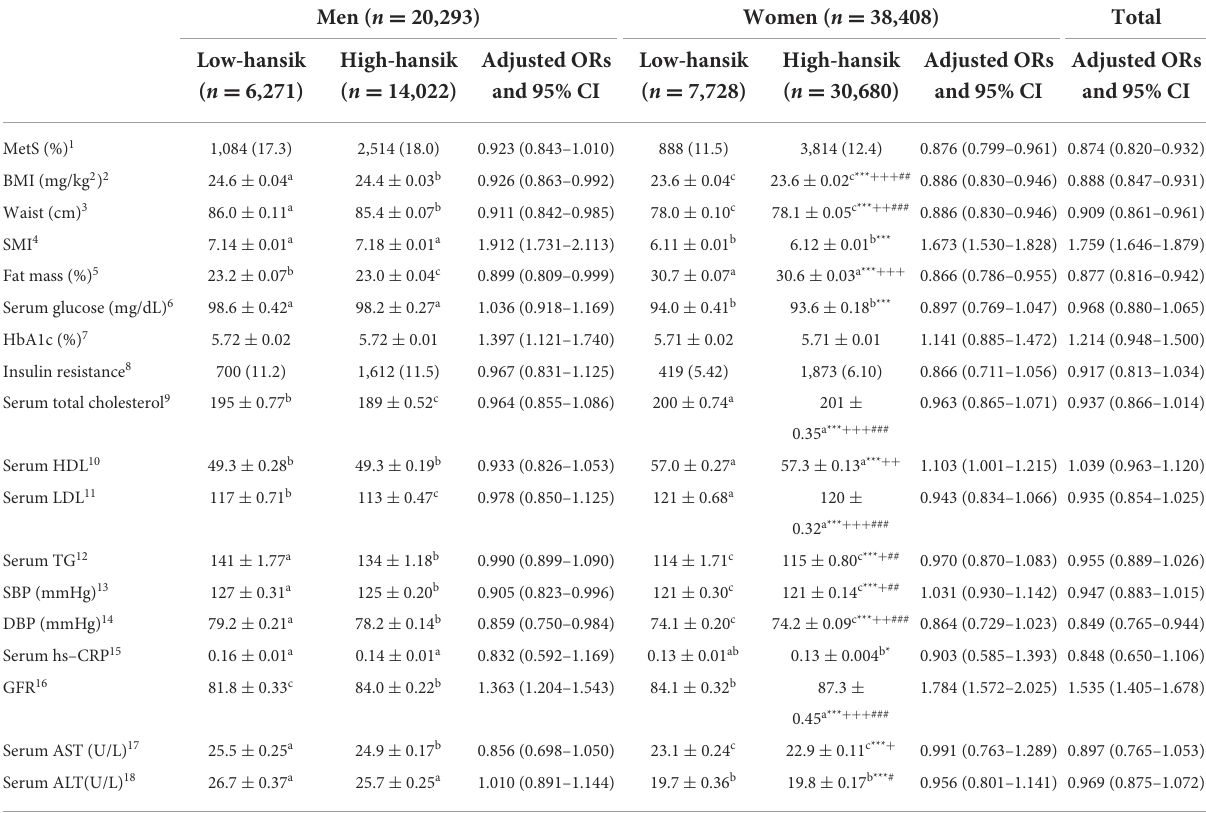
TABLE 6 Characteristics of metabolic parameters according to gender and hansik intake defined by the K diet -index score and their associations. Men ( n = 20,293) Women ( n = 38,408) Total Low-hansik High-hansik Adjusted ORs Low-hansik High-hansik Adjusted ORs Adjusted ORs ( n = 6,271) ( n = 14,022) and 95% CI ( n = 7,728) ( n = 30,680) and 95% CI and 95% CI